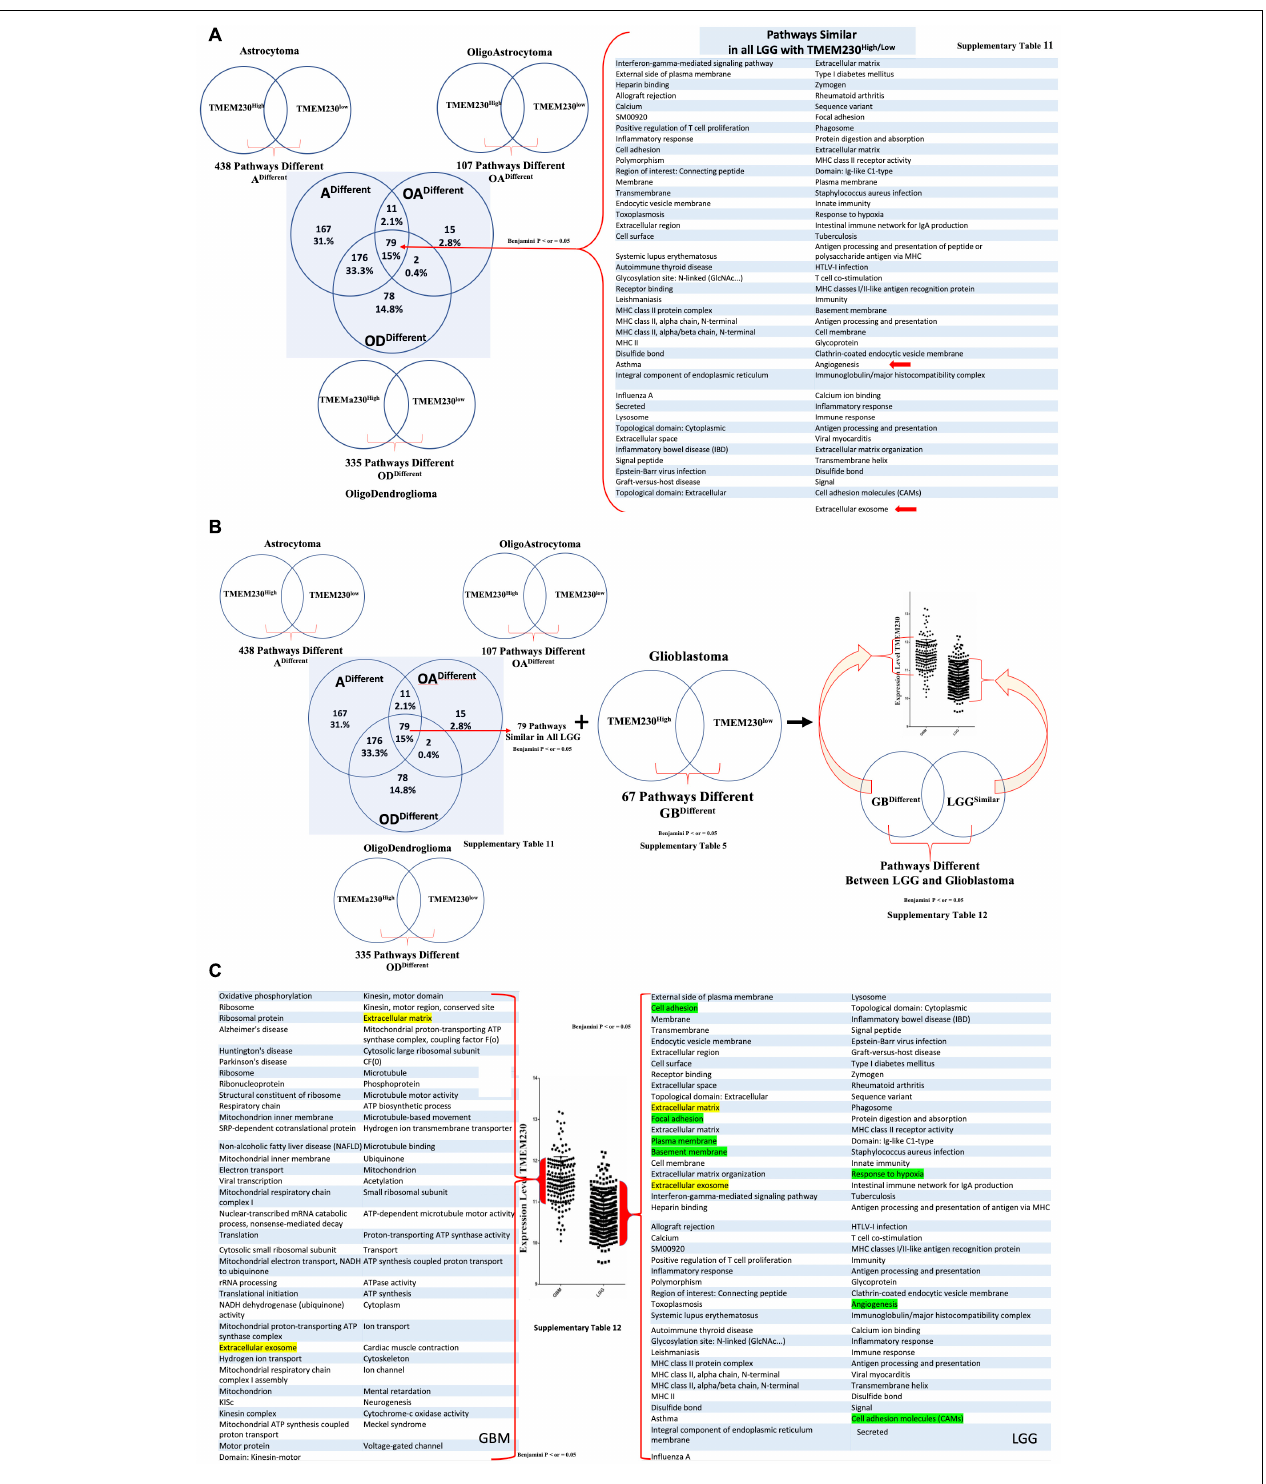
FIGURE 8 | All enriched pathways identified with high or low TMEM230 expression in diverse patient glioma tumors. (A) Enriched pathways identified common between high or low TMEM230 expression in all LGG of patient. (B) Scheme for identifying different pathways between high or low TMEM230 expression in LGG and glioblastomas. (C) Enriched pathways identified different between high or low TMEM230 expression in LGG and glioblastoma. See corresponding Supplementary Table 12 .